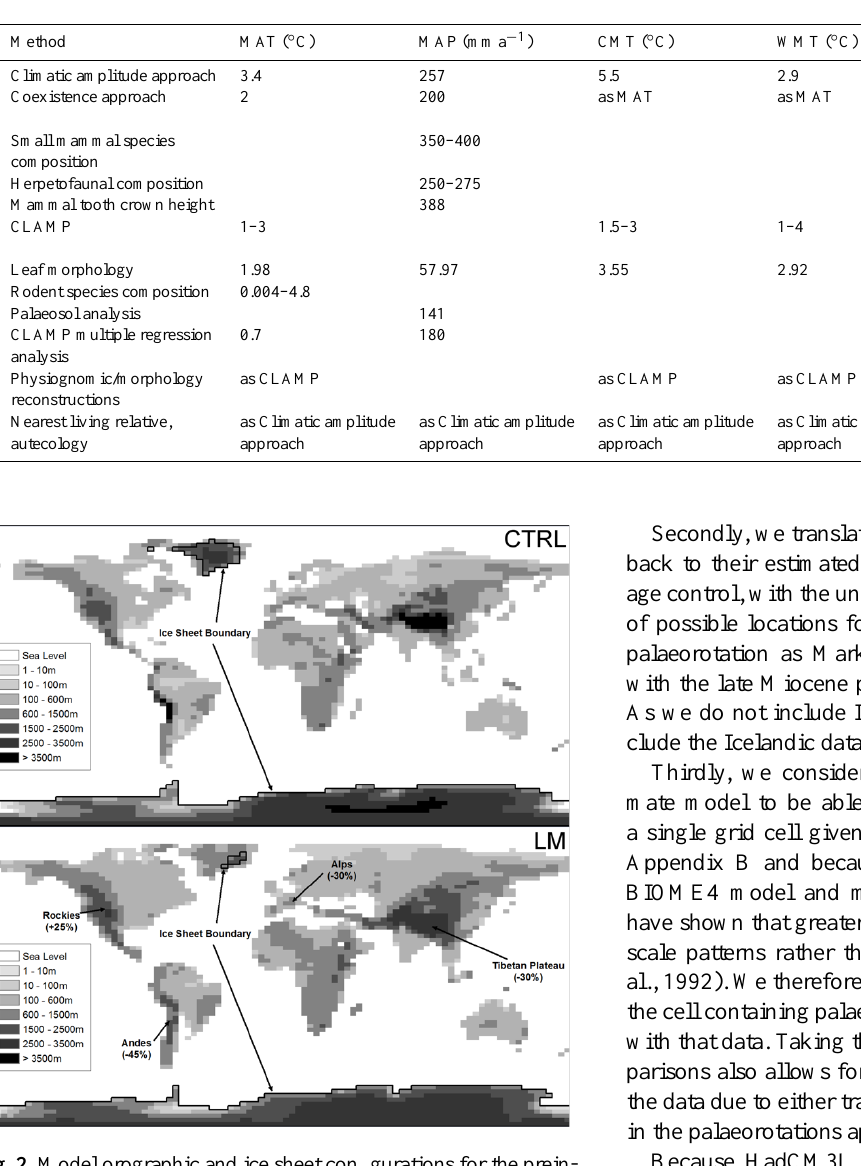
Table 1. Calibration errors for climate reconstructions of proxy data.